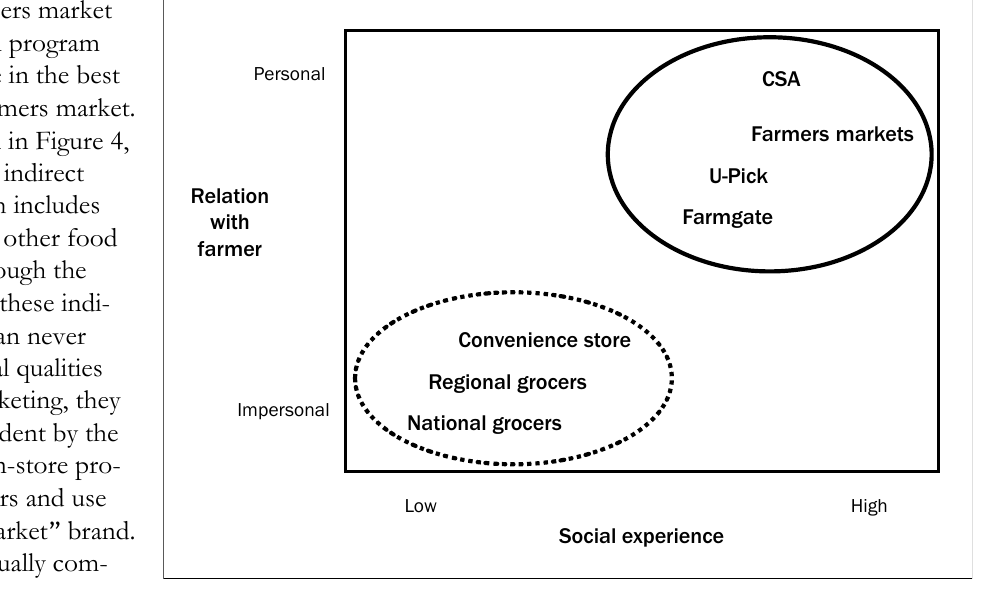
Figure 4. Strategic Group Map: Farm-Direct Food Retail The solid line shows a strategic group. The dotted line shows indirect